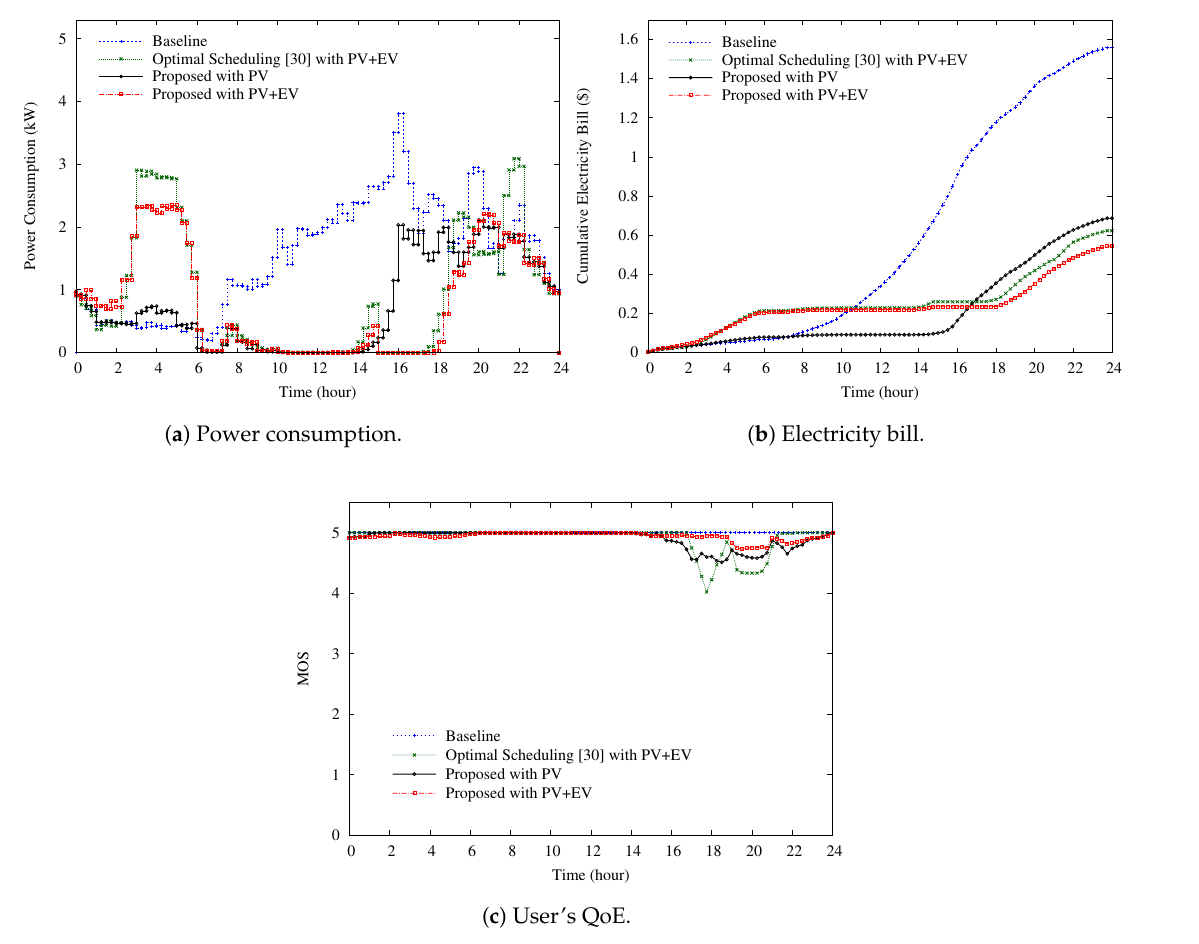
Figure 12. Performance comparison of various schemes under the scenario with PV and